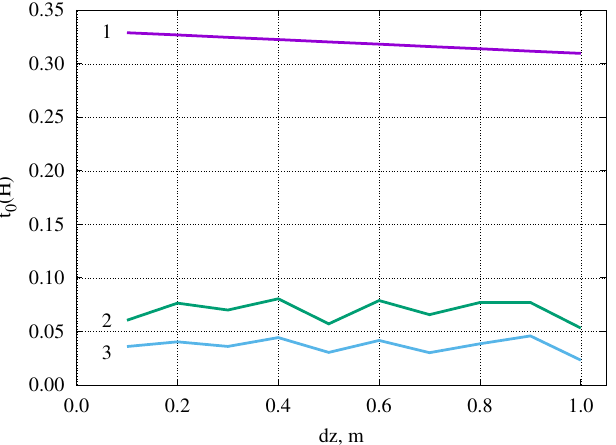
Figure 7. Dependence of the gap fraction estimate t 0 ( H ) on the thickness of differential layers dz ; 1—the pine stand, 2—the spruce stand, 3—the birch